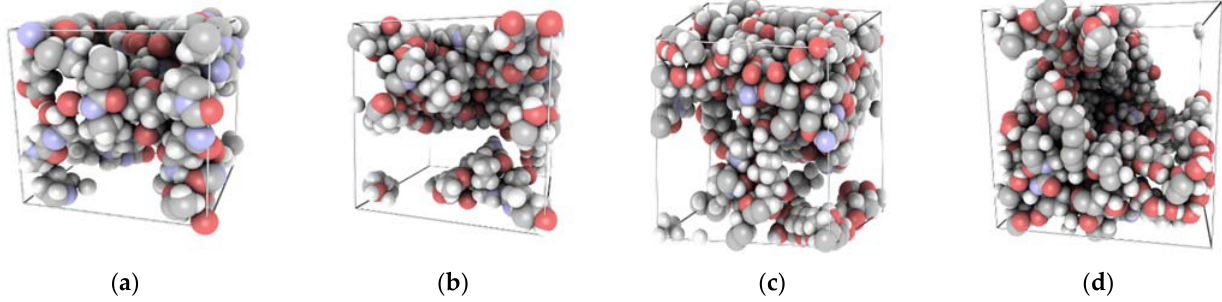
Figure 7. Four gelatin/PVA systems under periodic boundary conditions. The PVA content is: 0% ( a ), 40% ( b ), 62% ( c ), and 70% ( d ).